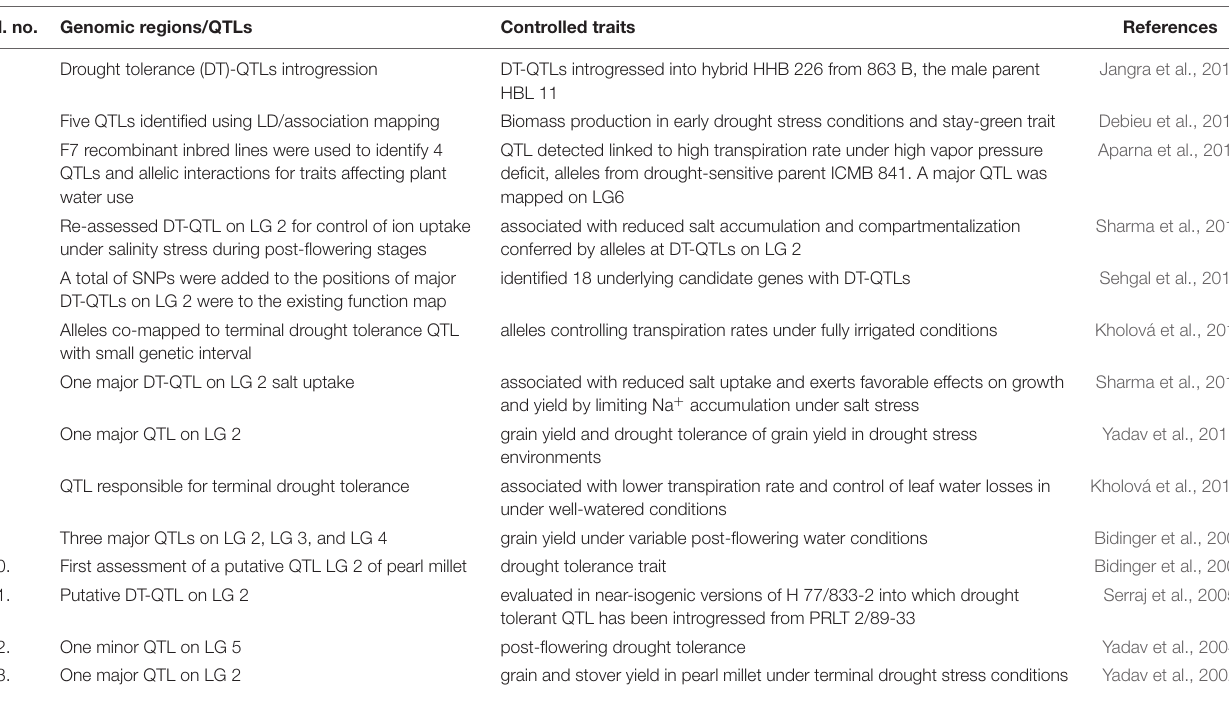
TABLE 4 | Details of genomic regions/quantitative trait loci (QTLs) associated with drought stress and other component agronomic traits related to drought in pearl millet. Sl. no. Genomic